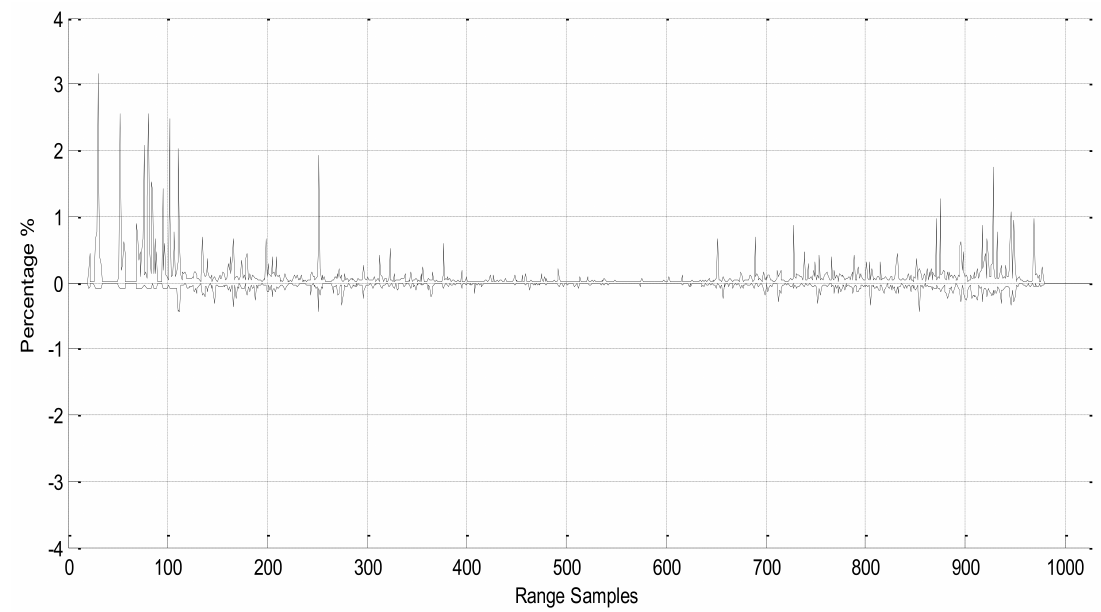
Figure 10. Difference in range-compressed data (range profile) by MATLAB and the proposed SAR processor.